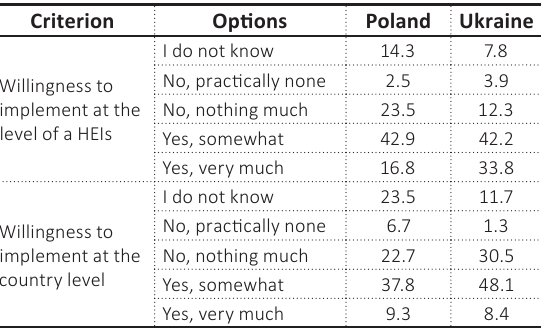
Table 5. Respondents’ answers to the question: